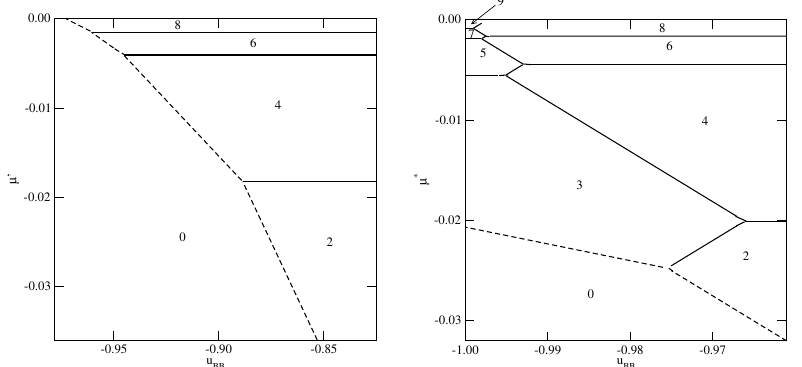
Figure 6. The ground state phase diagrams for the systems with V A = − 0.2 and different values of V B = − 0.9 ( left panel) and − 1.0 ( right panel). The numbers mark the numbers of layers stable in different